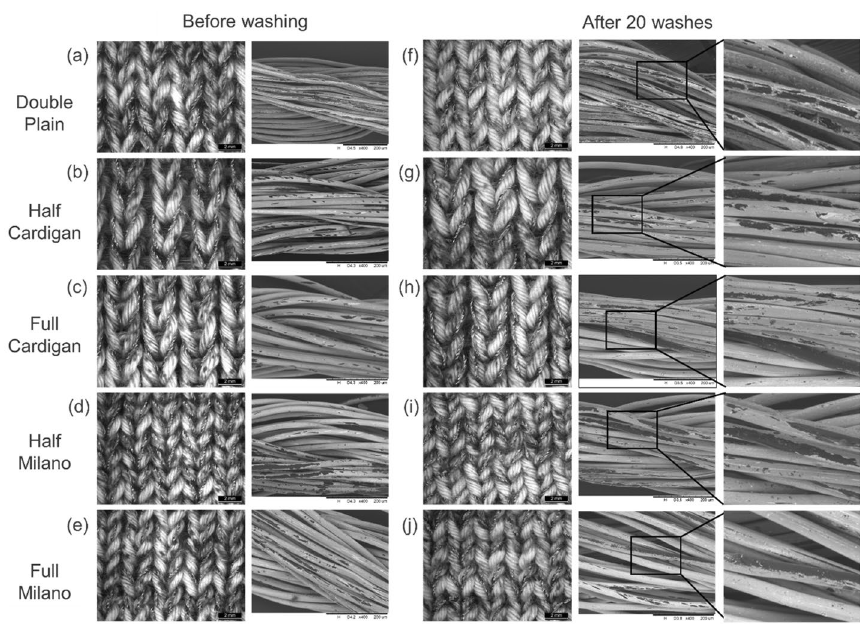
Fig. 5 Optical microscopic and SEM images of knitted textiles: a double plain before washing; b half cardigan before washing; c full cardigan before washing; d half milano before washing; e full milano before washing; f double plain after 20 washes; g half cardigan after 20 washes; h full cardigan after 20 washes; i half milano after 20 washes; and j full milano after 20